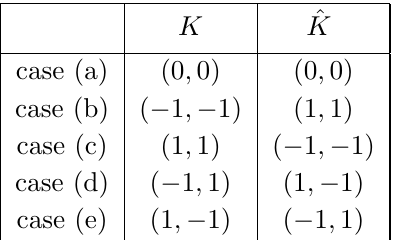
Table 9 . We display the SL(2) GL(1) charge for both K and ˆ K in each of the cases considered. × Case (a) breaks the SL(4) symmetry whilst the remainder preserve